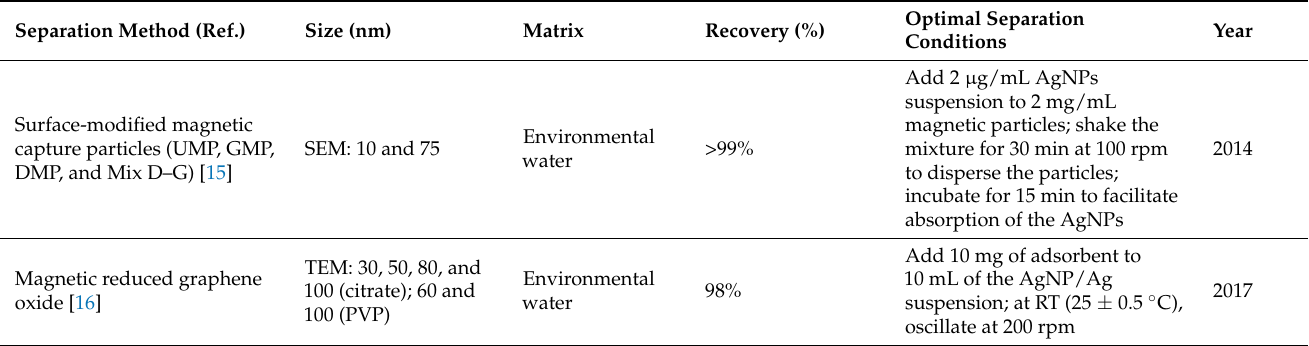
Table 1. Overview of AgNPs separation based on magnetic